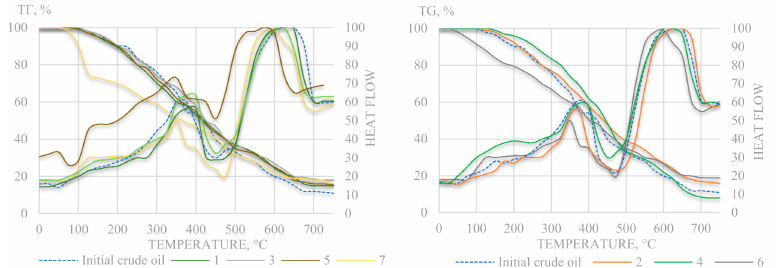
Figure 8. Thermogravimetric oil curves before and after experiments 1–7 (dotted lines are heat